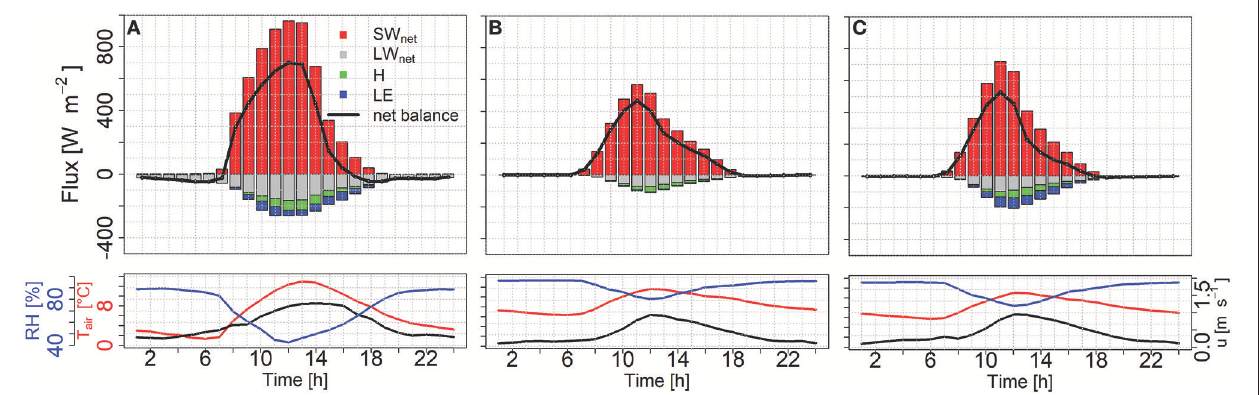
FIGURE 14 | Energy balance on the glacier, with measured radiative fluxes and modeled turbulent fluxes based on AWS from 2014 during pre-monsoon (A) , monsoon (B) , and post-monsoon (C)